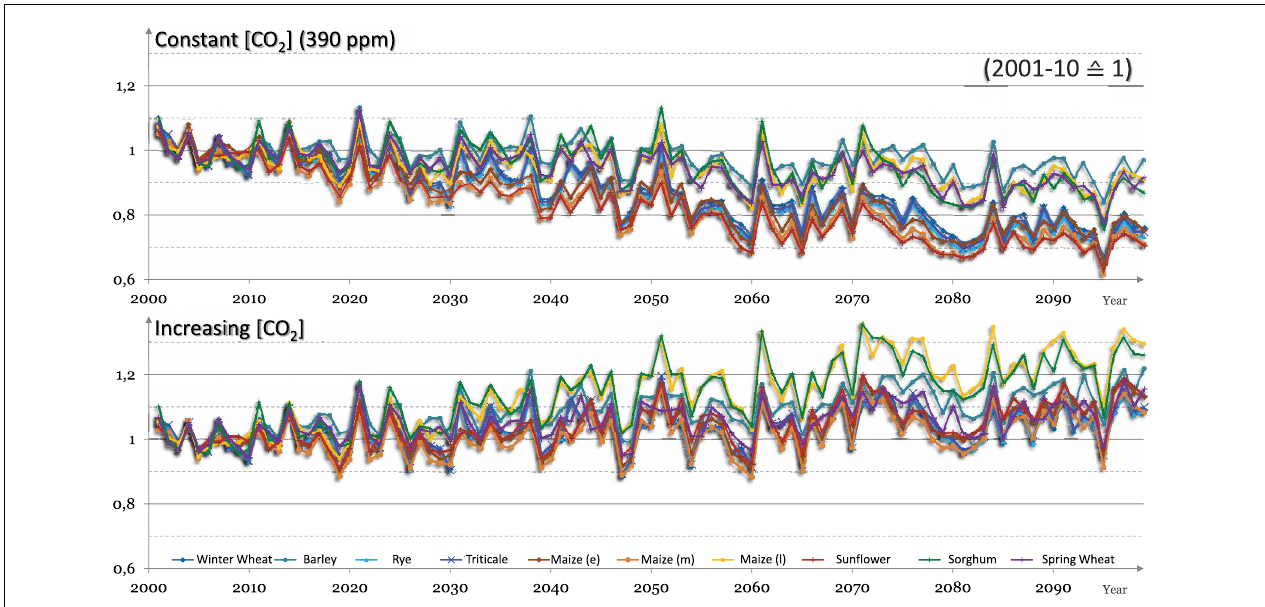
FIGURE 5 | Biomass development with constant and changing [CO 2 ]. Top: biomass development throughout the 21st century if [CO 2 ] is hold constantly at 390 ppm-Below: Same modeling approach as above, only [CO 2 ] is changed for each year according to SRES scenario A1B.